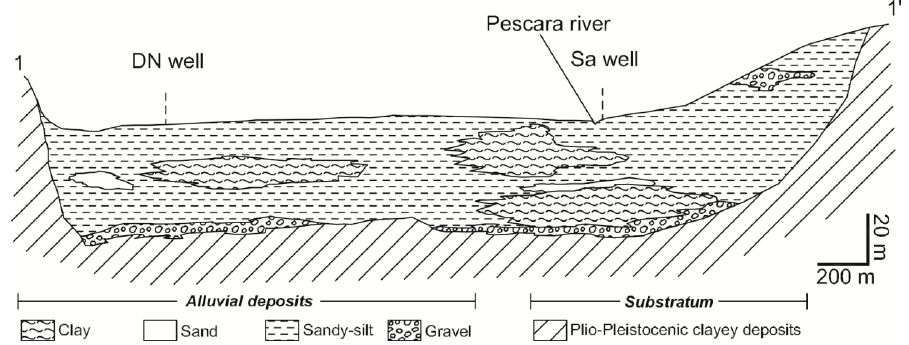
Figure 2. Schematic geolithological section with a 10× vertical exaggeration (Cross section 1–1' in Figure 1).